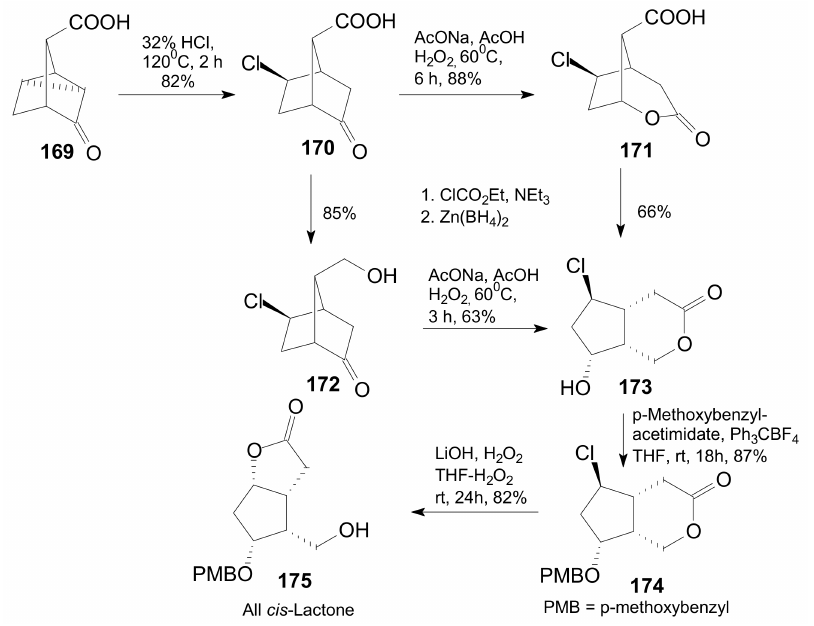
Scheme 35. The synthesis of all- cis -Corey lactone 175 starting from the isomer tricyclic ketone 169 . For the synthesis of isoprostanes of type 15-F 3t , characterized by a cis-correlation of the hydroxyls and of the side chains to the cyclopentane ring, but a trans-correlation between the hydroxyls and the side chains, another strategy was developed by a new route to the key intermediates 177 and 179 (Scheme 36) [111]. δ -Lactone 179 , used for the synthesis of 15-F 3t -IsoProstane and its 15-epimer [111], was synthesized from the optically active intermediate (+)-176 , readily obtained from 1,3-cyclooctadiene in five steps. After the protection of the hydroxyl groups and subsequent ozonolysis of the double bond and reductive work-up, the bicyclic diol 177 was obtained at a 78% yield. The diol was then selectively oxidized in the presence of the efficient catalyst 178 [111,112] for mild oxidative lactonization of 1,4-diols or 1,5-diols 177 , giving the lactone 179 at a 91% yield. The diol intermediate 177 was enzymatically regio-selectively monoacetylated to the hydroxyl linked to the longer chain [113] and was also used for the synthesis of